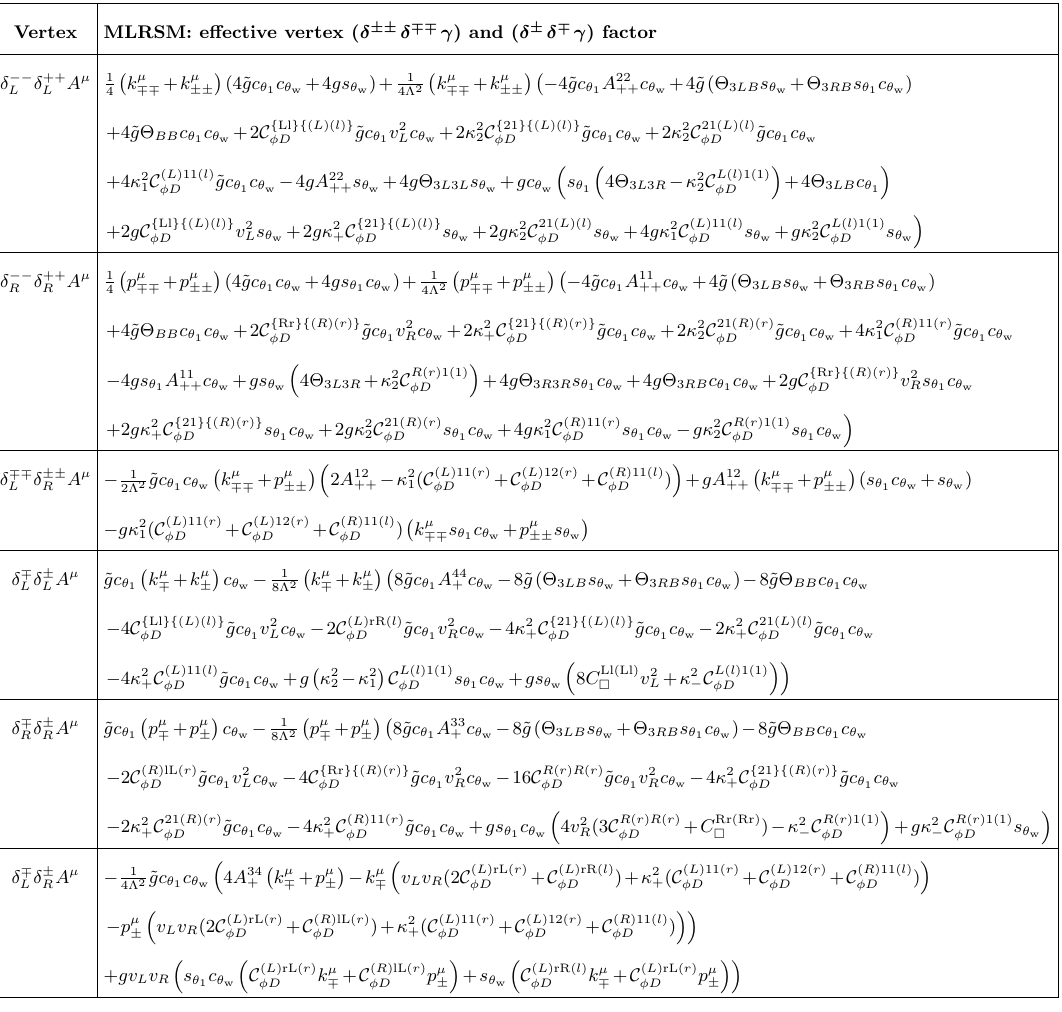
Table 42. MLRSM: coupling of a pair of doubly charged scalars ( (cid:14) (cid:6)(cid:6) ) and singly charged scalars ( (cid:14) (cid:6) ) with photon ( A (cid:22) ). Here, s (cid:18) momenta of (cid:14) (cid:6)(cid:6)